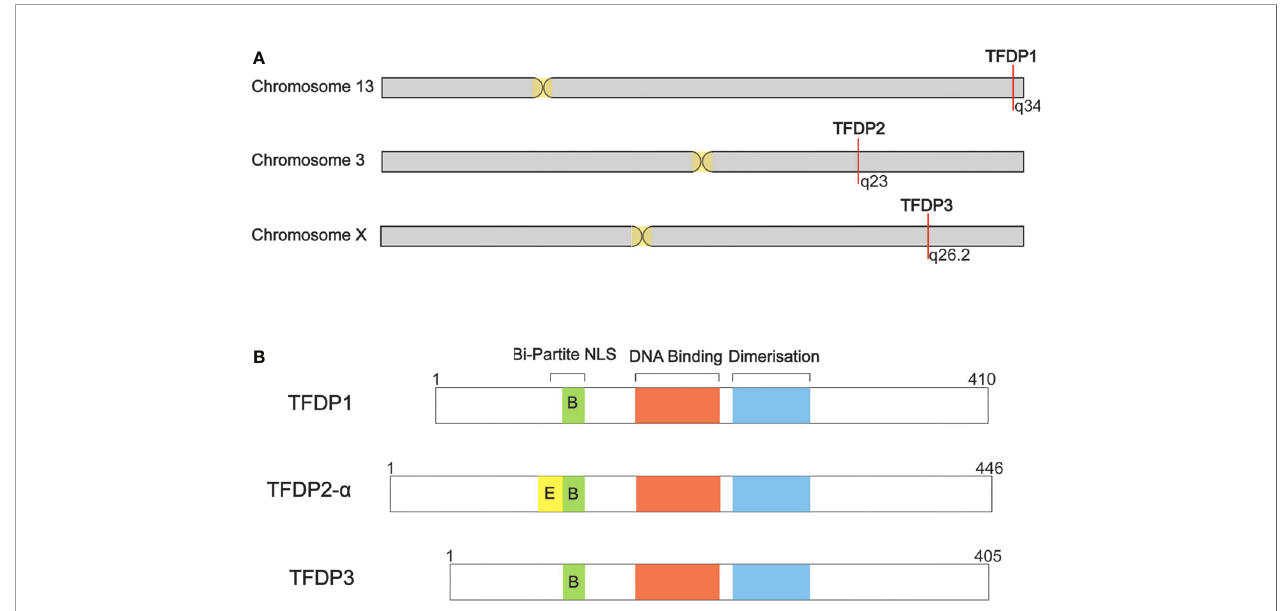
FIGURE 1 | Summary of TFDP3 and other DP family members. (A) Location of DP family in chromosome. TFDP1 and TFDP2 locate in autosome, 13q34 and 3q23, respectively. Differently, TFDP3 locates in X chromosome, q26.2. (B) Structural comparison of DP family members. DP proteins share a conserved DNA-binding and dimerization domain. TFDP2- a has integrated Bi-Partite NLS; TFDP1 and TFDP3 have defective Bi-Partite NLS. The length of proteins is